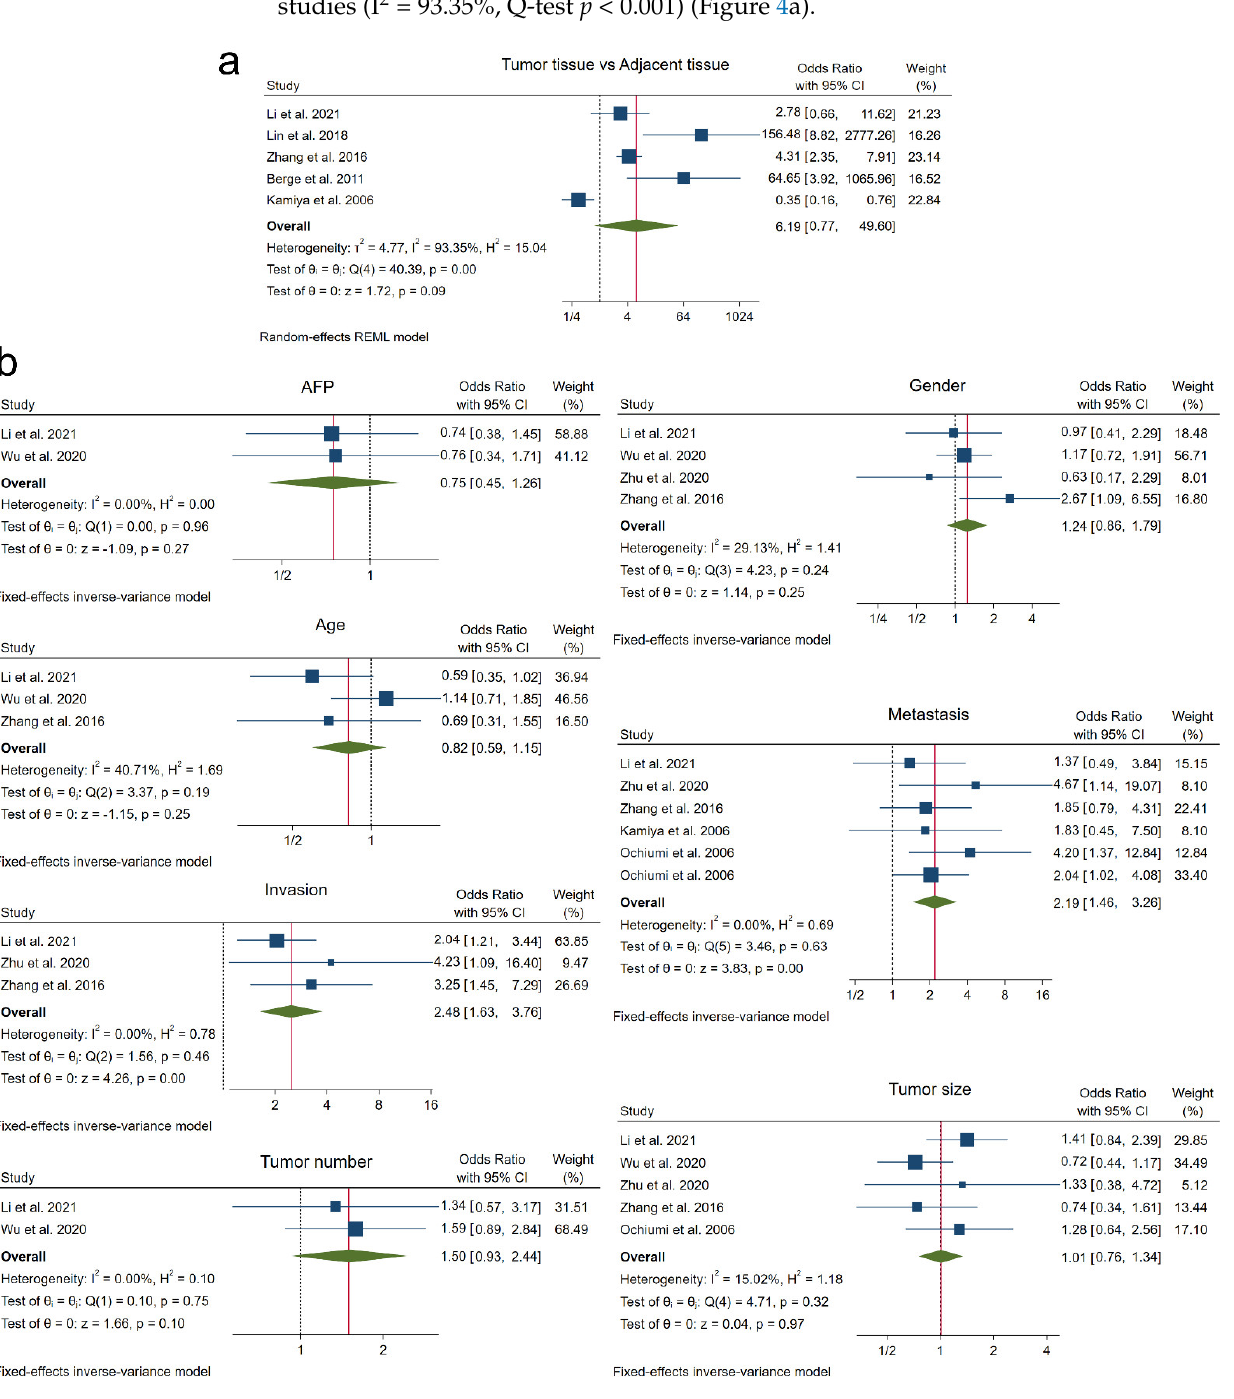
Figure 4. Forest plots showing OR for the evaluation of the relationship between NRP1 overex- pression and ( a ) tumor pathogenesis, and ( b ) different clinicopathological features in cancer pa- tients. AFP, alpha-fetoprotein; CI, confidence interval; OR, odds ratio; REML, Restricted Maximum Likelihood